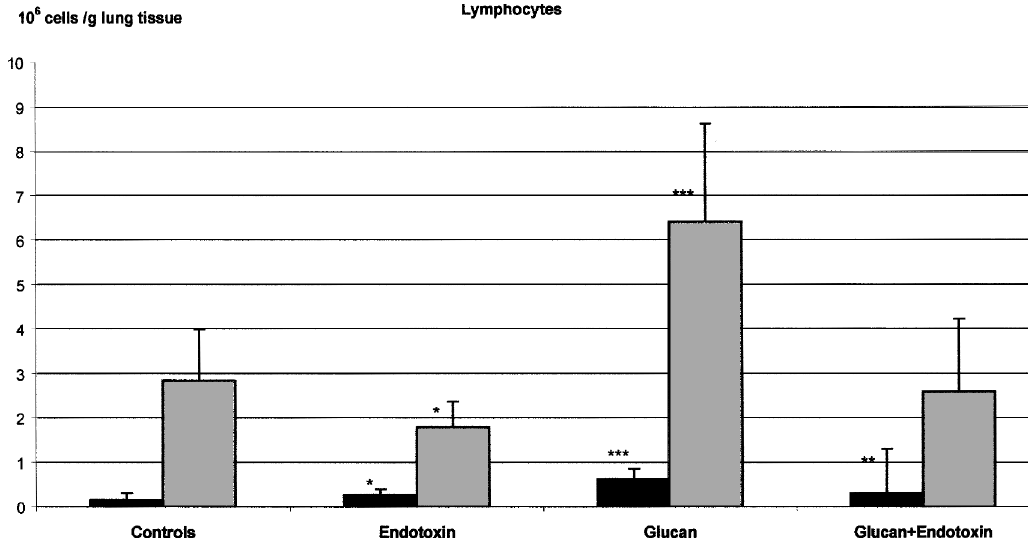
FIG. 2. The numbers of lymphocytes in lung lavage fluid (black bars) and lung interstitium (grey bars). The results are presented as mean values with standard deviations. * p < 0.05, ** p < 0.01, *** p < 0.001 as compared to